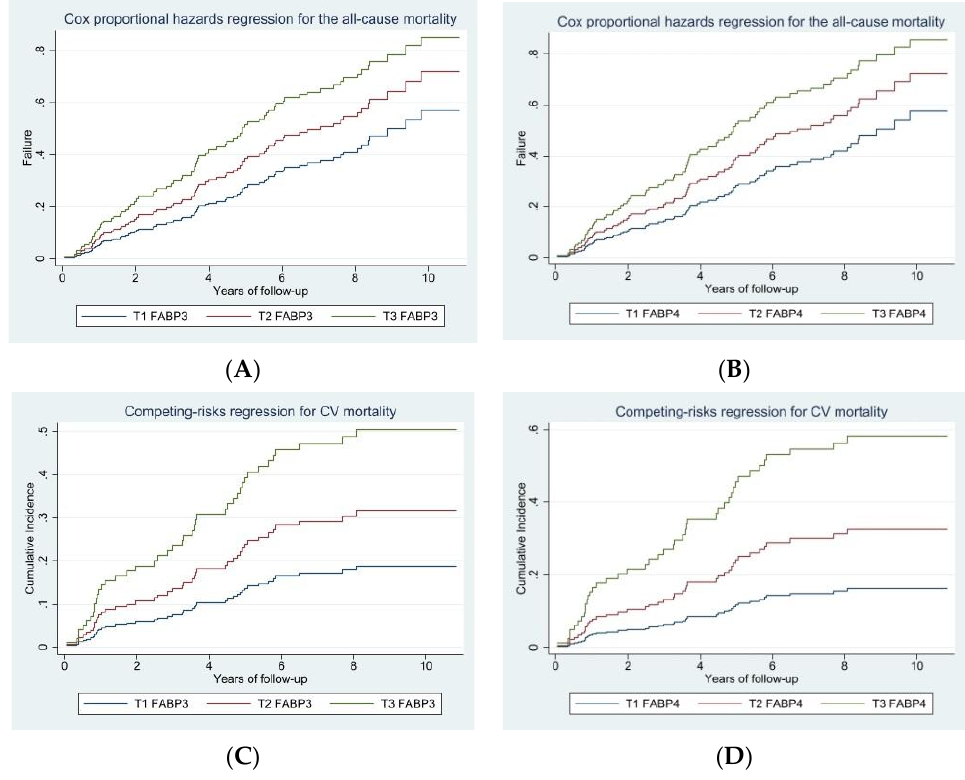
Figure 1 . Both all-cause ( A , B ) and CV ( C , D ) mortality stratified by the tertiles of serum FABP3 ( A , C ) and FABP4 ( B , D ) in T2D patients. Data adjusted by age, gender, ischemic etiology, NYHA III and IV, HF duration, LVEF, NTproBNP, obesity and eGFR were expressed as incidence of mortality by Cox proportional hazards and competing-risks regression. Overall p -value < 0.05. Table 2. Cox regression models for the FABP3, FABP4 concentration and all-cause mortality in subjects with